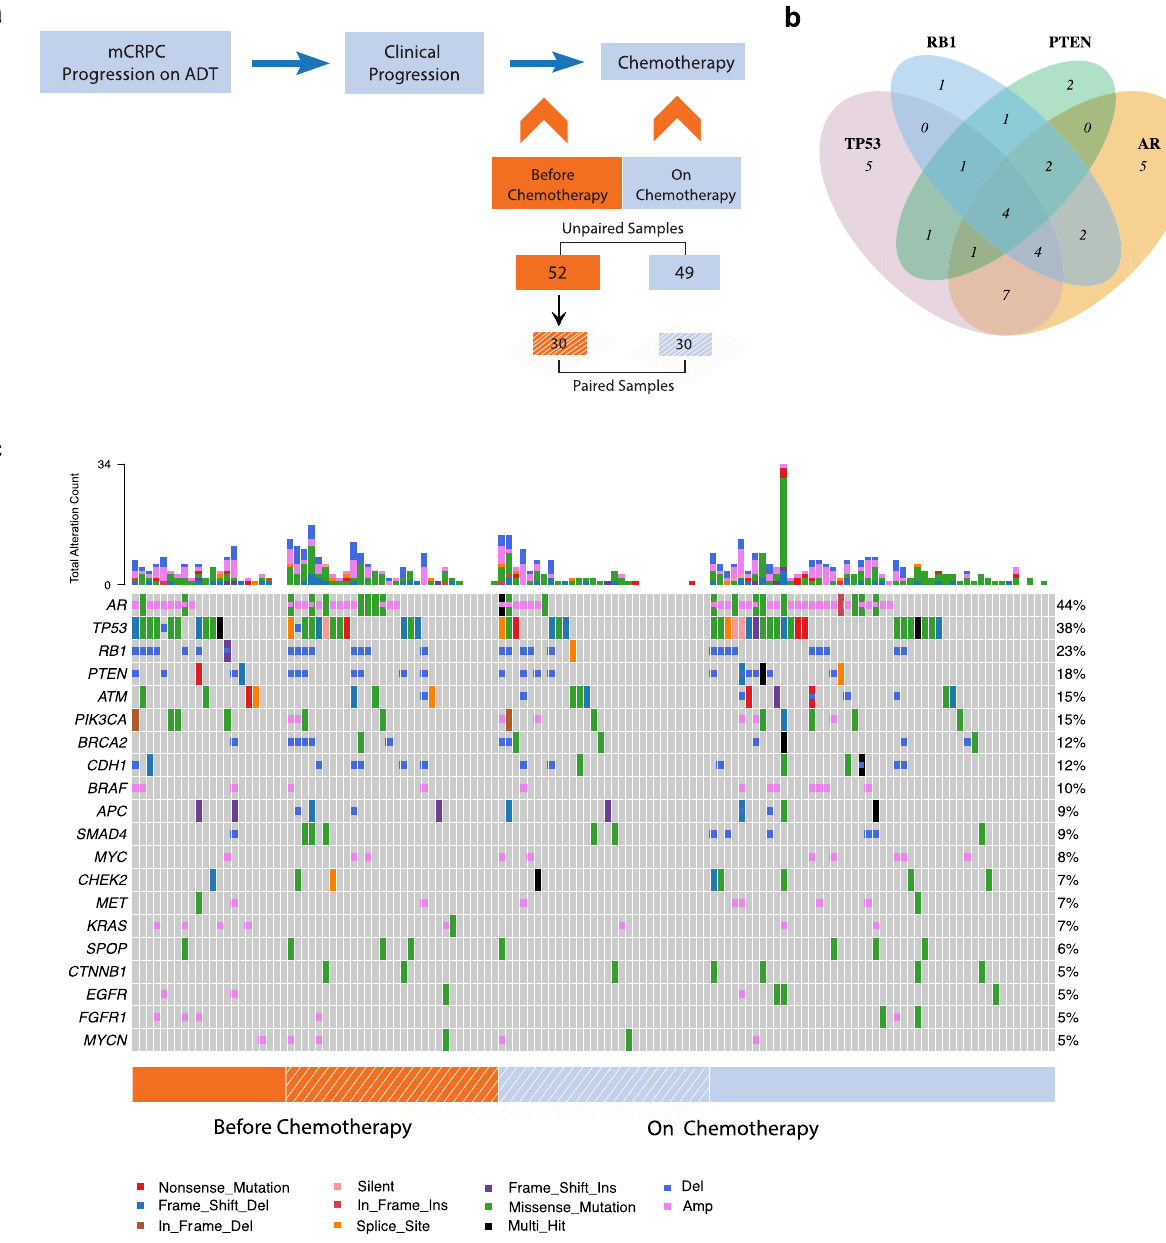
Figure 1. Landscape of somatic alterations detected in mCRPC patients before and during chemotherapy. ( a ) Plasma samples were collected from mCRPC patients following clinical progression on androgen deprivation therapy (ADT), prior to the initiation of chemotherapy (n = 52). Thirty of these patients were serially sampled during chemotherapy to create a subset of paired samples (before chemotherapy, n = 30; after 3–4 chemotherapy cycles, n = 30). Forty-nine samples were collected from an independent group of patients following 3–4 chemotherapy cycles (n = 49). ( b ) Venn diagram illustrating the overlap of the 4 most frequently altered genes ( AR , TP53 , RB1 and PTEN ) detected at baseline in individual patients. ( c ) Heatmap of somatic alterations including SNVs and CNVs detected across all samples collected before and after 3–4 cycles of chemotherapy. The percentage of alterations detected in each gene across all patient samples is shown to the right of the heatmap. The total number of alterations detected in each patient sample is shown in the bar graph above the heat map. This figure was created by manuscript authors using the Adobe Illustrator 2020 (https:// www. adobe. com/ produ cts/ illus trator. html) ( a ), VennDiagram (version 1.7.1) (https:// cran.r- proje ct. org/ web/ packa ges/ VennD iagram/ index. html) ( b ), and Bioconductor (https:// www. bioco nduct or. org/ packa ges/ relea se/ bioc/ html/ mafto ols. html) (version 3.14) ( c ) software